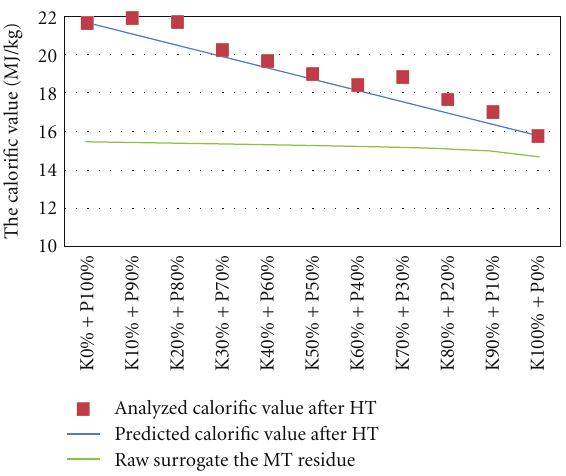
Figure 8: Change of the calorific value of the hydrothermal products by changing the mixture ratio of the paper and kimchi (hydrothermal reaction temperature (cid:2) 220 ◦